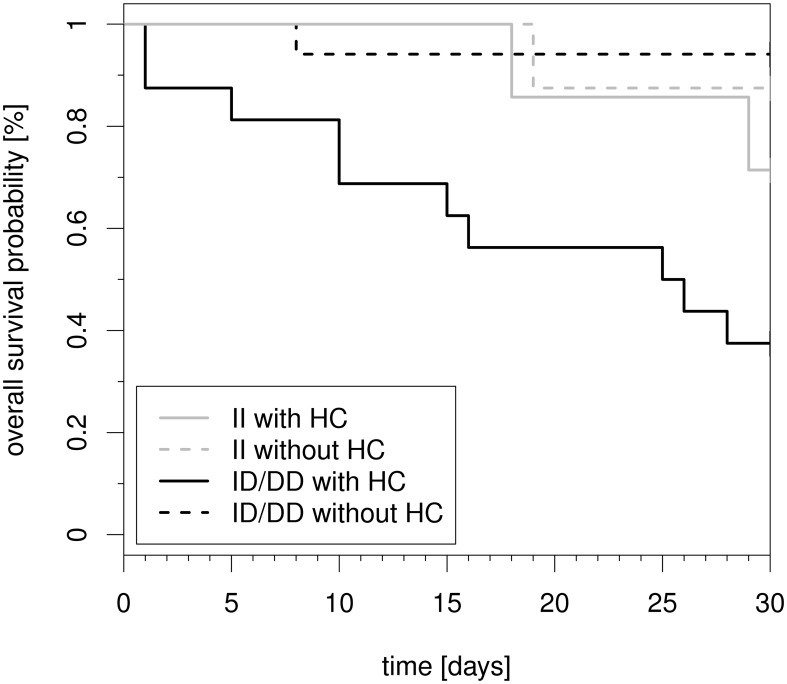
Kaplan–Meier plot of 30-day mortality of patients with septic shock stratified both by NFKB1 promoter polymorphism (−94ins/delATTG) and hydrocortisone therapy.Kaplan-Meier estimators for the four subgroups in 2x24 matched patients of the propensity score analysis. DD  =  homozygous deletion genotype. ID  =  heterozygous deletion genotype. II  =  homozygous insertion genotype.